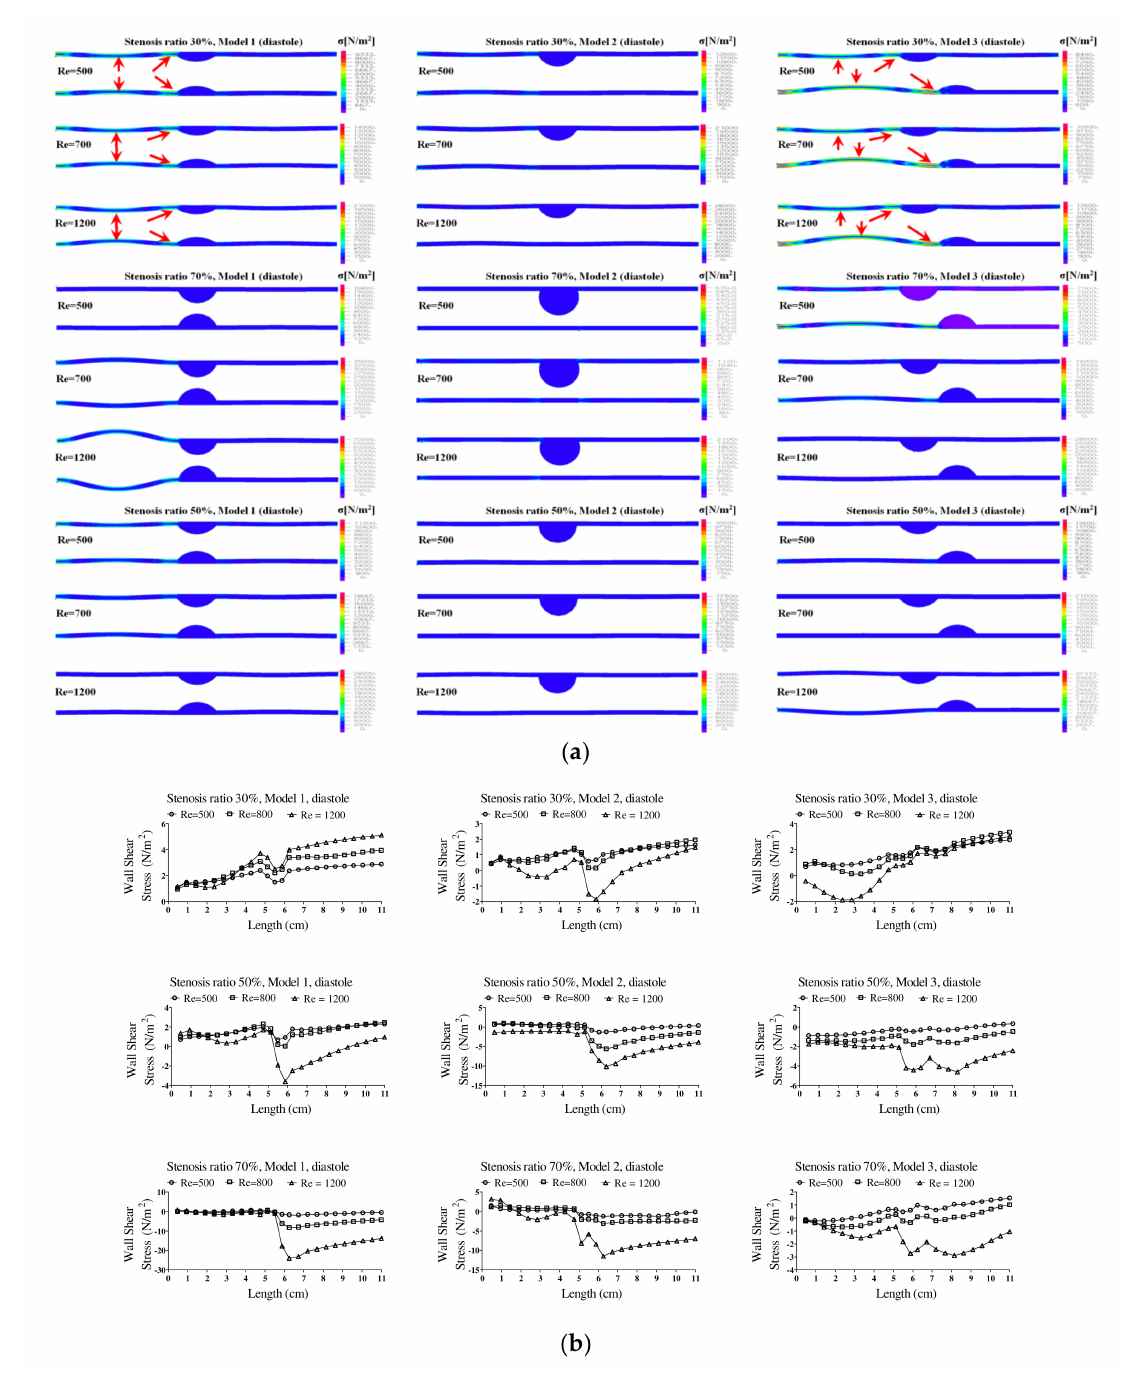
Figure 6. The wall load distribution and wall shear stress on the wall of blood vessels in the pulsatile flow. ( a ) Diastolic wall load distribution, ( b ) diastolic wall shear